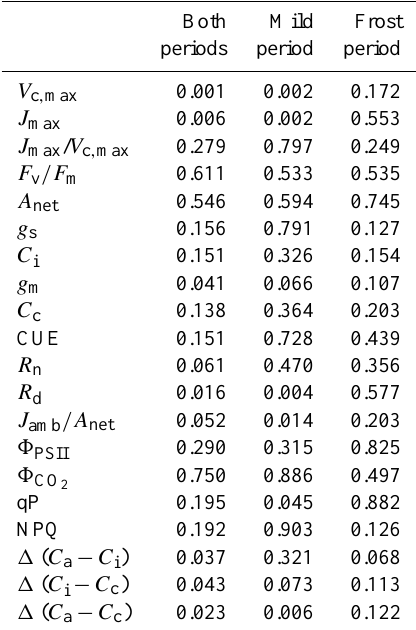
Table 1. P -values of Student’s t -tests for the differences between sunlit and shaded leaves of Q. ilex